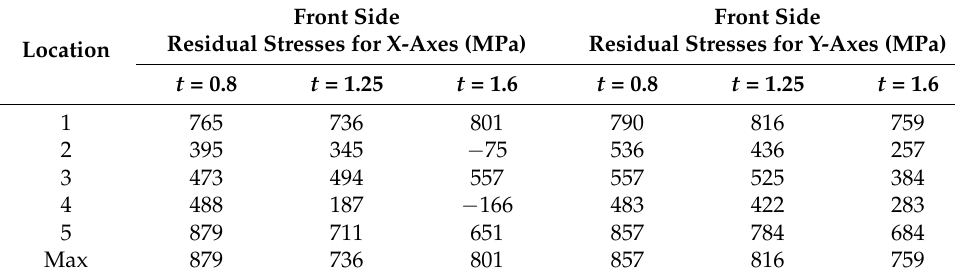
Front Side Residual Stresses for Y-Axes